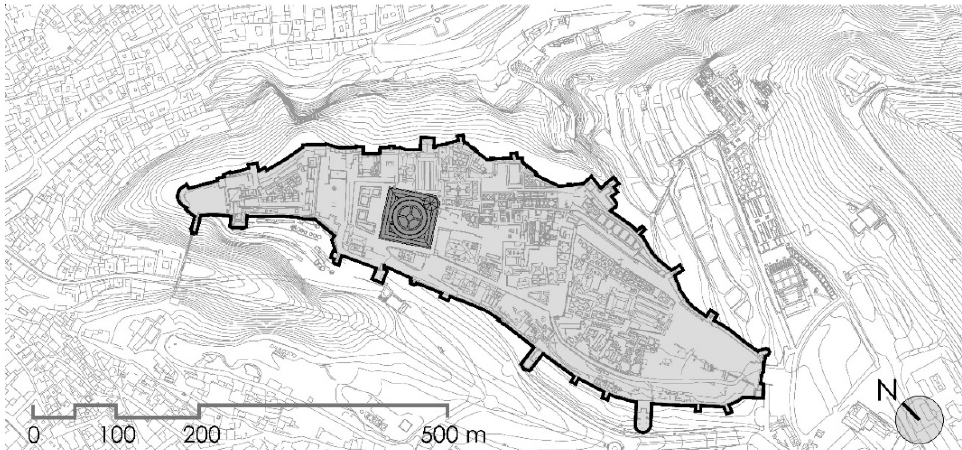
Figure 1. Location plan of the Palace inside the Alhambra.